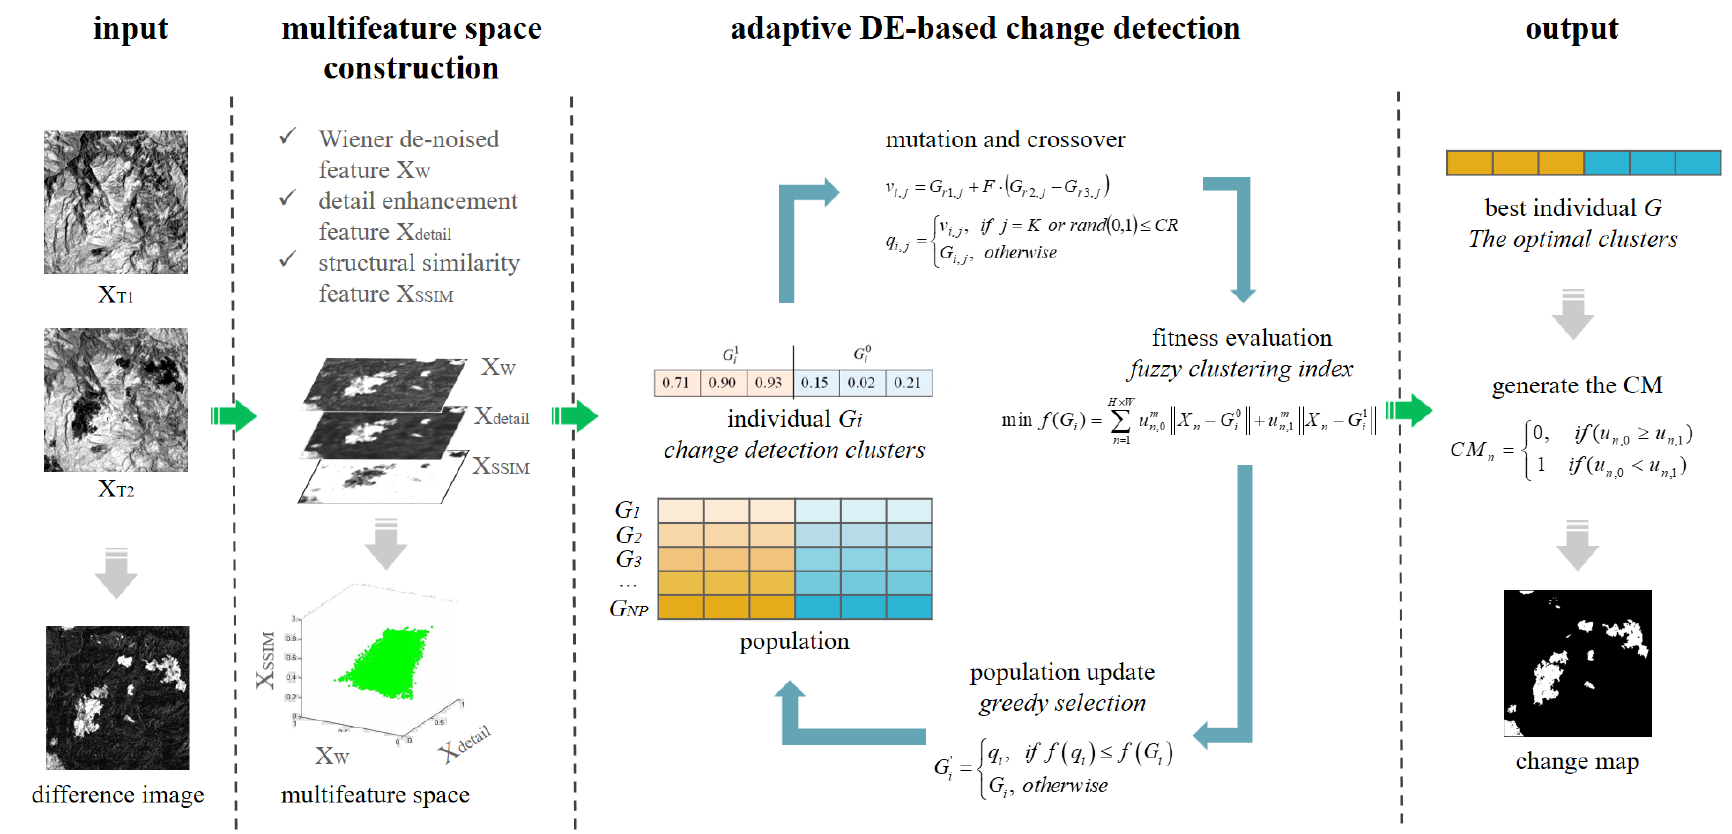
Figure 1. Framework of the proposed M-DECD. ( a ) Given two registered images, the DI is generated by images subtraction. ( b ) Three image features are extracted to construct a multi-feature space, including the Wiener de-noised feature, detail enhancement feature and structural similarity feature. ( c ) The optimal clusters in the multi-feature space are obtained by the adaptive DE algorithm. ( d ) Generate the binary CM according to the optimal clusters and fuzzy membership matrix.